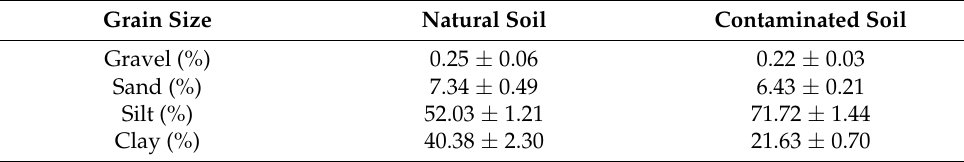
Table 4. Impact of diesel contamination in grain-like size distribution of soil. Grain Size